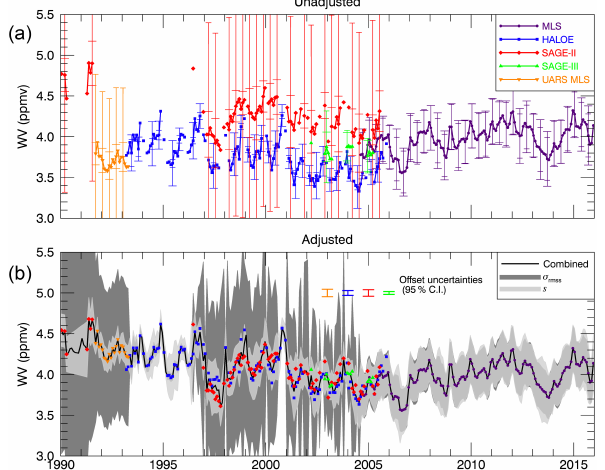
Figure 8. Top: the uncorrected source water vapor time series in the Figure 9. Same as in Fig. 8 but for 30–40 ◦ S latitude band at 68hPa, along with the source standard de- viation ( s k , wide error bars) and root-mean-sum-of-squares (RMSS) uncertainty values ( σ rmss , narrow error bars). Bottom: the offset- k corrected source measurements along with the combined (“anomaly filled”) product. The lighter and darker gray shaded regions show the combined RMSS uncertainty ( σ rmss , dark gray) and the com- bined standard deviation ( s , light gray), respectively. The vertical error bars in the lower panel show the 95% confidence interval of the offset uncertainties for the 30–40 ◦ S latitude band at 68hPa.